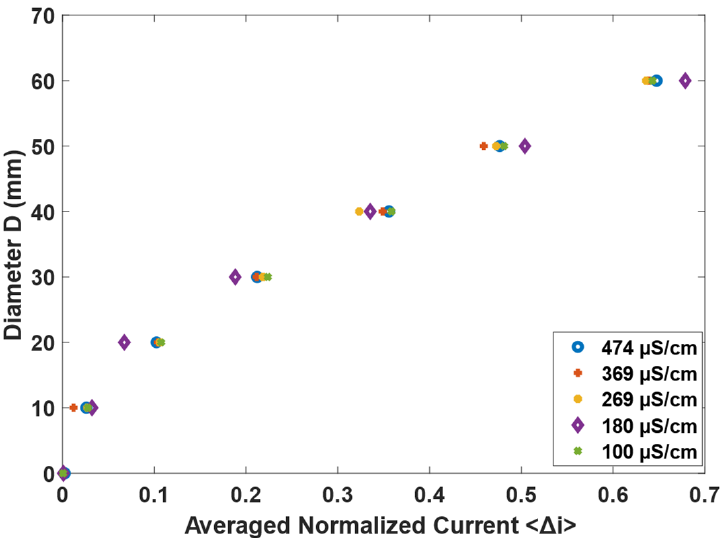
Figure 7. Relation between the normalized current and the phantom size for different water conductivities, represented by different symbols.